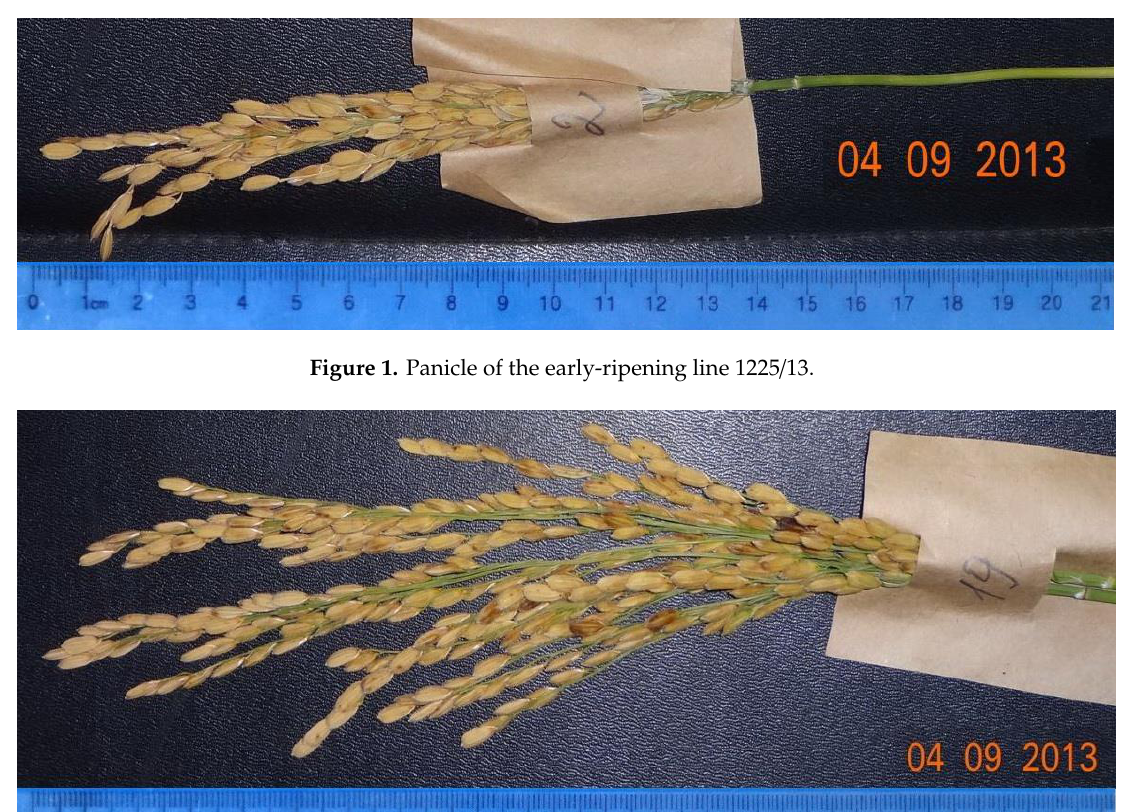
Figure 2. Panicle of the mid-ripening line 1396/13.